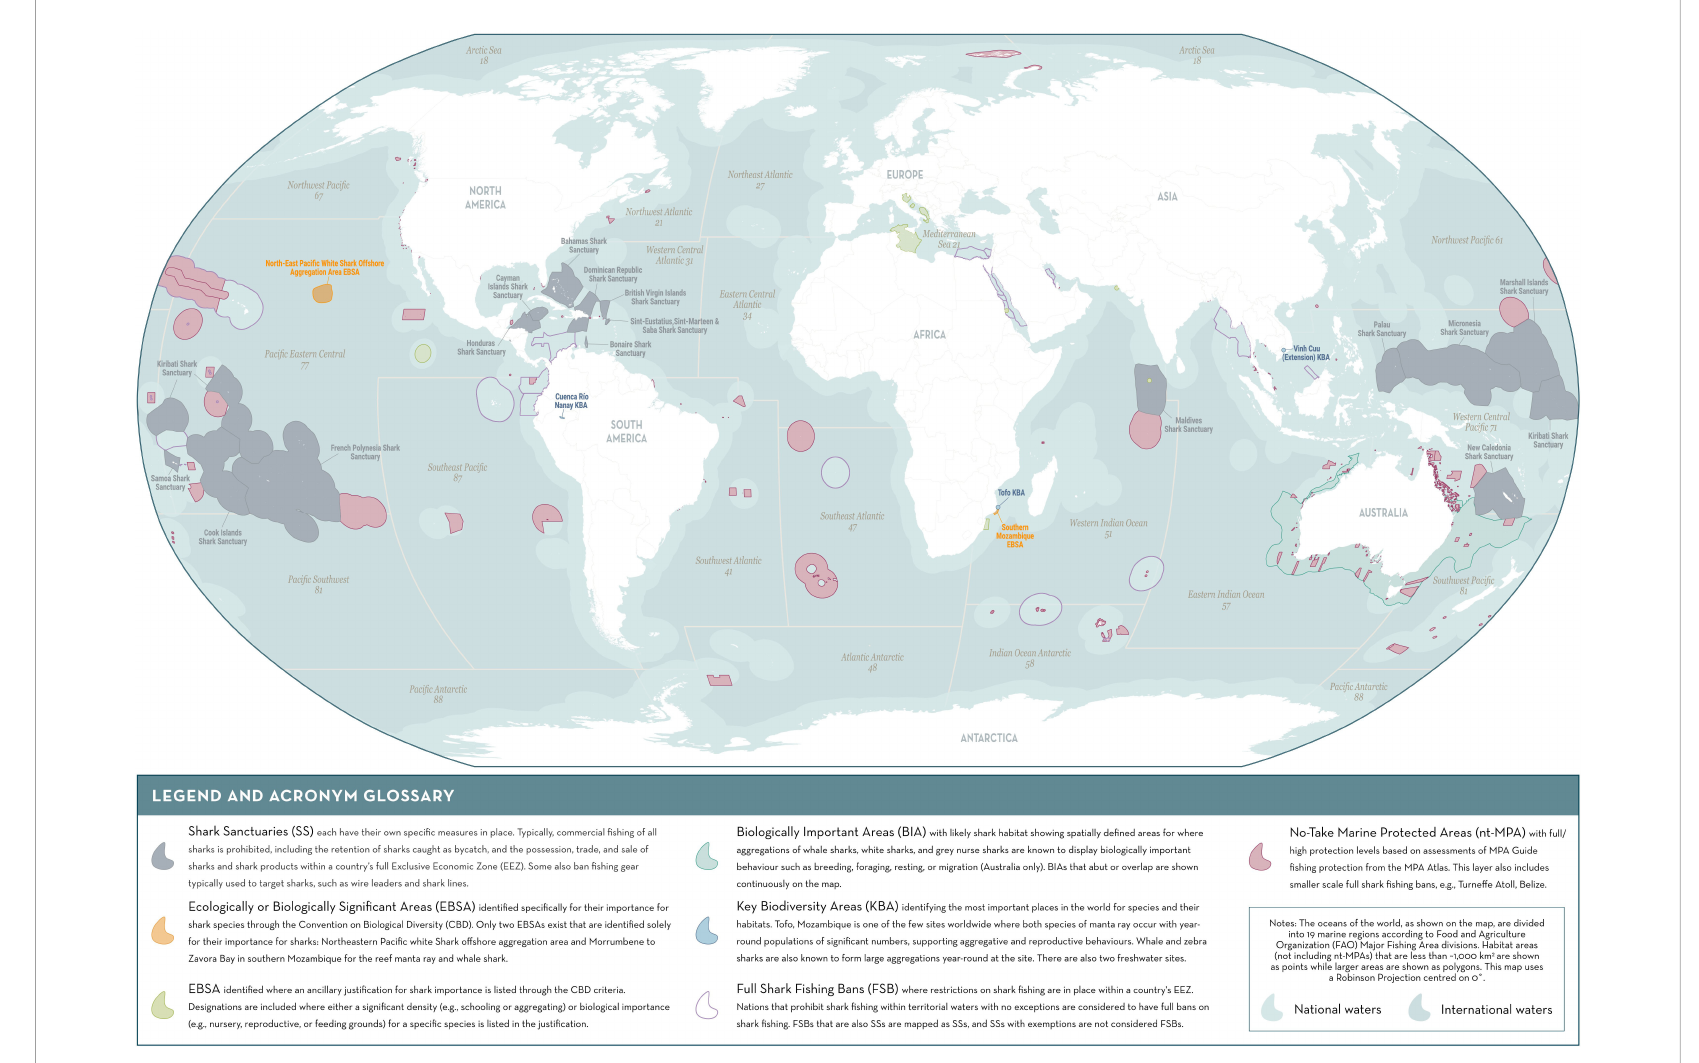
FIGURE 1 Baseline map of shark area-based conservation. Detailed information on each area delineated is provided in Supplementary Material